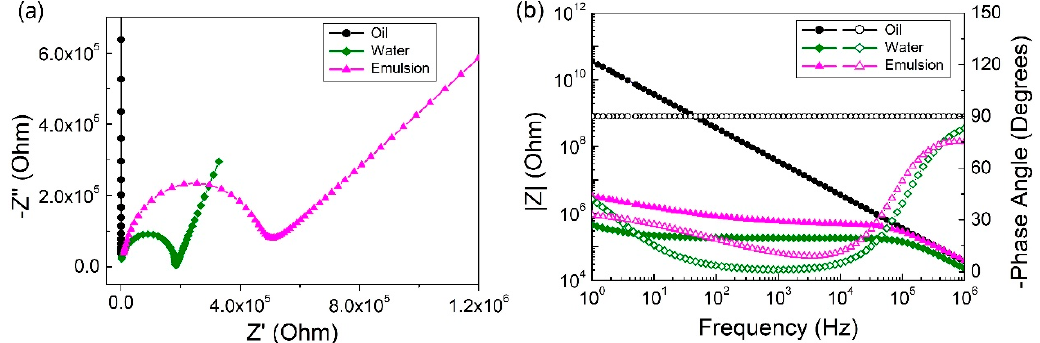
Figure 1. ( a ) Nyquist and ( b ) Bode diagrams for oil, water, and Pickering emulsion. The solid symbols are the impedance modulus-frequency curve and the hollow symbols are the phase angle-frequency curve in the Bode diagram ( b ).